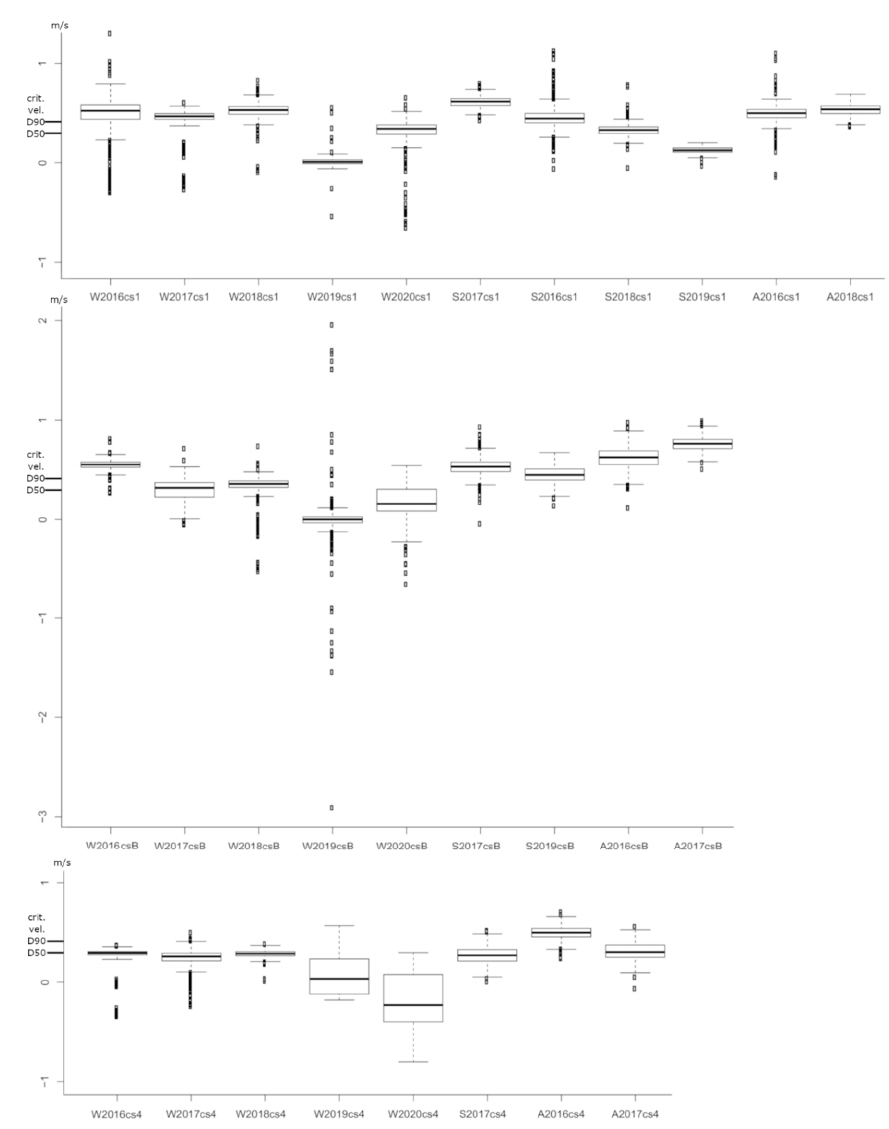
Figure 11. The boxplots of streamwise velocity (m / s) of the deepest cells at CS1, CSB, and CS4 measurement locations during each measurement time. The critical velocity thresholds for the movement of the largest measured D50 and D90 grain sizes are shown. Note that the deepest cells are at different depths depending on the measurement times. The boxplots show the median line, 1st and 3rd quartiles (25 and 75 percentile ranges) within the boxes, maximum observations below upper and lower fences (i.e., the fence is 1.5 times the difference between the 3rd and 1st quartiles), and outliers (dots). In particular, scattering occurred on W2019 at CSB, as there were wide ranges in the outlier values.